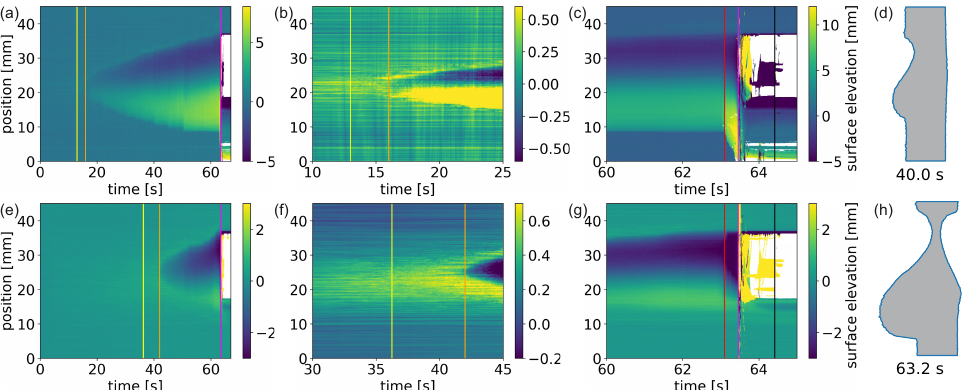
Figure 2. Temporal surface change at the front side ( a – c ) and back side ( e – g ) of an aluminum plate irradiated with a laser of 4 kW power and a spot diameter of D 4 σ = 22mm. The vertical lines represent: yellow—start of surface roughening; orange—start of melting; red—start of accelerated material downward flow; magenta—perforation; black—laser turn off. In ( d , h ), cross-sections at two selected times are